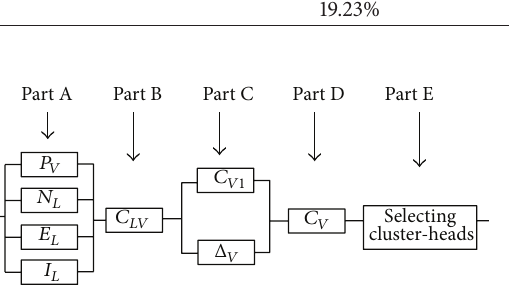
Figure 7: VLWBC parallel-series